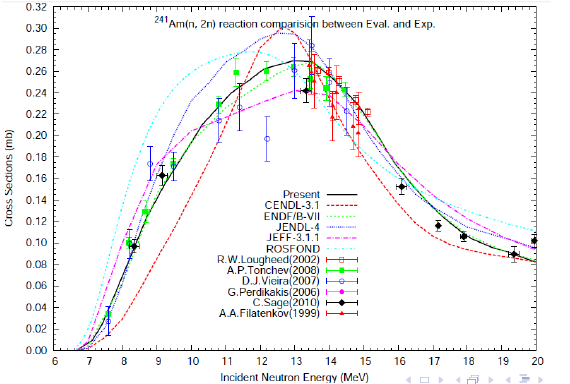
Fig. 17. The comparison of the updated 241 Am(n,2n) in CENDL- 3.2 and the other evaluated and the experimental data [13].